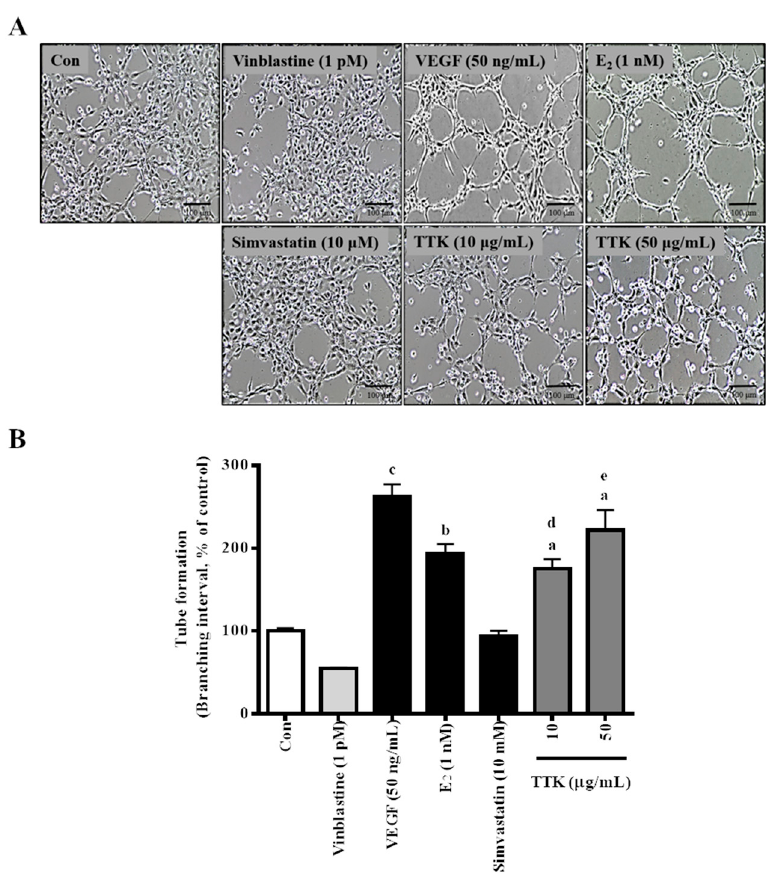
Figure 3. Effect of TTK on in vitro tube formation in HUVECs. ( A ) Cells were treated with different concentration of TTK (10, 50 µ g / mL), 50 ng / mL VEGF, or 1 nM 17 β -estradiol, 10 µ M Simvastatin on matrigel. After 12 h of incubation, tube formation was observed using a microscope (magnification, 4 × ) and photographed. ( B ) The tube formation was analyzed by measuring each branch interval value using Image J analyzer (angiogenesis ability). Data are expressed as the mean ± SEM. of three experiments. a p < 0.05, b p < 0.01, c p < 0.001 vs. control, d p < 0.01, e p < 0.001 vs. Simvastatin.